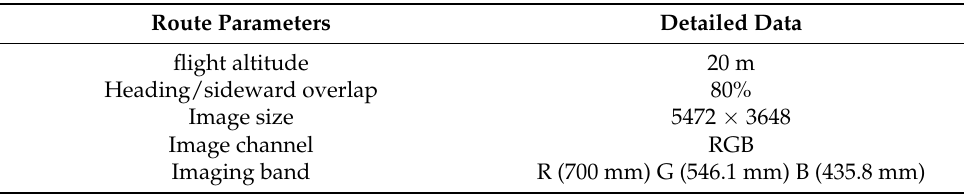
Table 1. Aerial photography and image parameter.